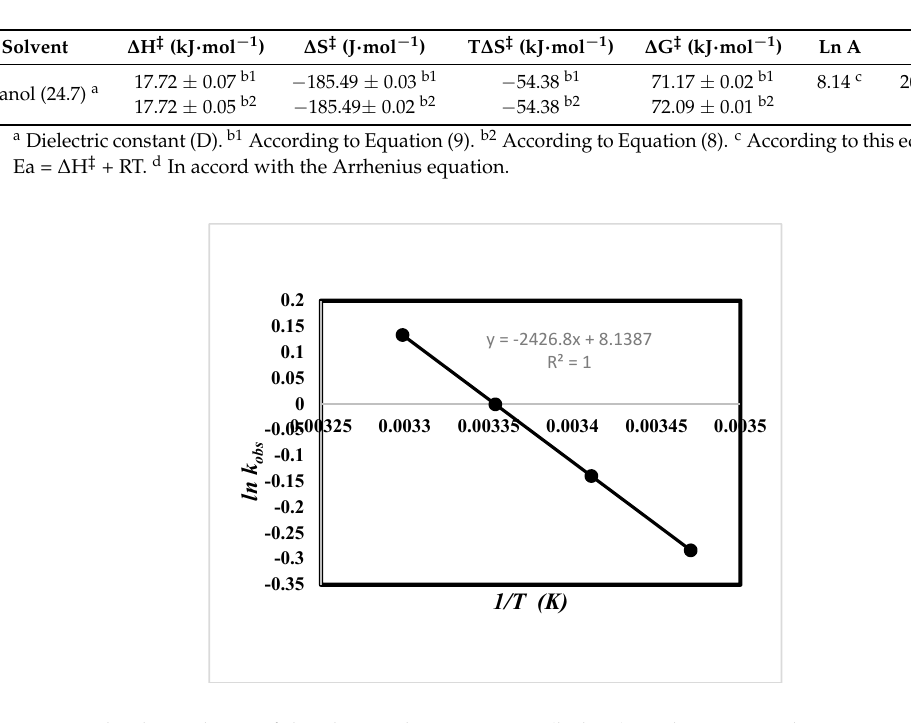
Figure 6. The dependence of the observed rate constant (ln k obs ) on the reciprocal temperature for the reaction between compounds TPP, DMAD and MA in ethanol at a wavelength of 320 nm.